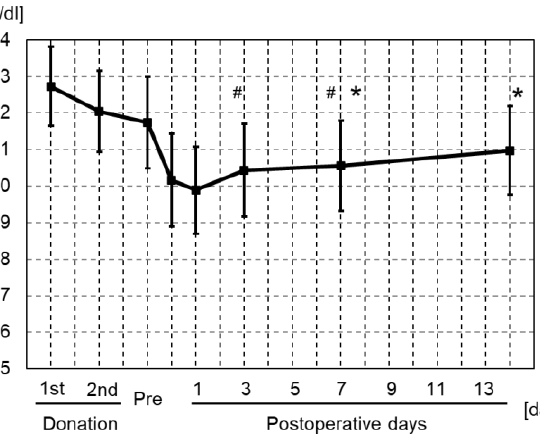
Figure 1. Mean Hb concentrations during the operative period for all patients. The lowest Hb con- centration was 9.9 ± 1.2 g/dL on postoperative day 1. On postoperative day 14, the Hb concentration in that patient had recovered to 11.0 g/dL. The error bars indicate the standard deviation. * p < 0.05 compared with Hb of postoperative day 0. # p < 0.05 compared with Hb of postoperative day 1.